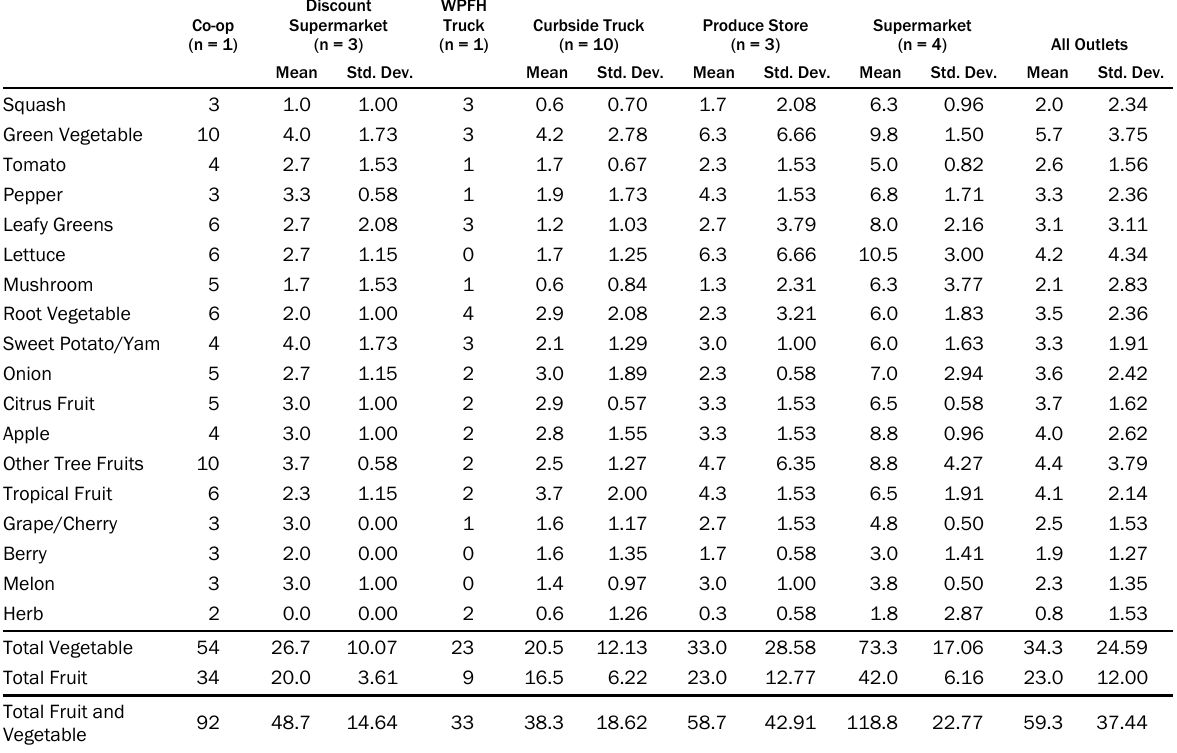
Table 3. Varieties of Fruit and Vegetables by Outlet Type Discount